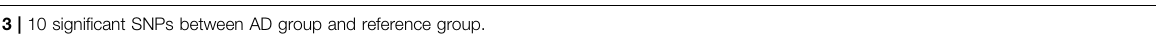
TABLE 3 | 10 signi fi cant SNPs between AD group and reference group. SNPs